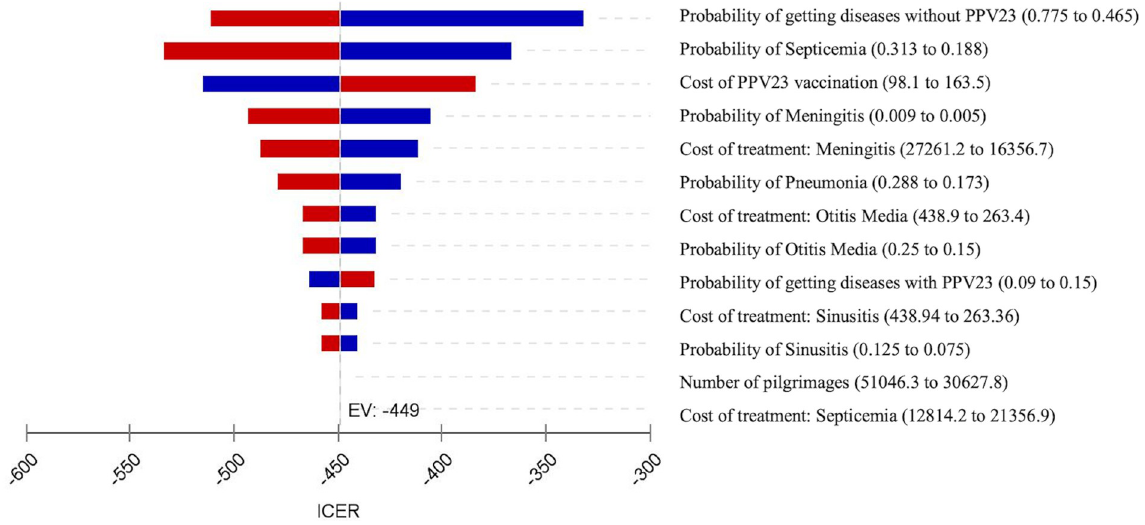
Fig 2. Tornado chart presenting a one-way sensitivity analysis for PPV23 vaccination. The tails of each bar represent the differences in ICERs with low (left) and high (right) parameter values. The maximum and minimum values for each variable are presented in brackets. EV: Expected value.